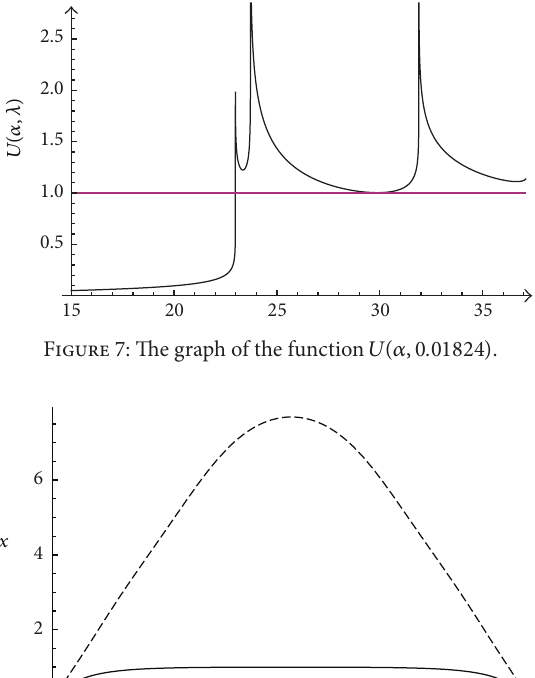
Figure 10: Three solutions of problem (15), (10), 𝛼 ≈ 24.0606 , 𝛼 ≈ 29.4663 , and 𝛼 ≈ 32.5832 .